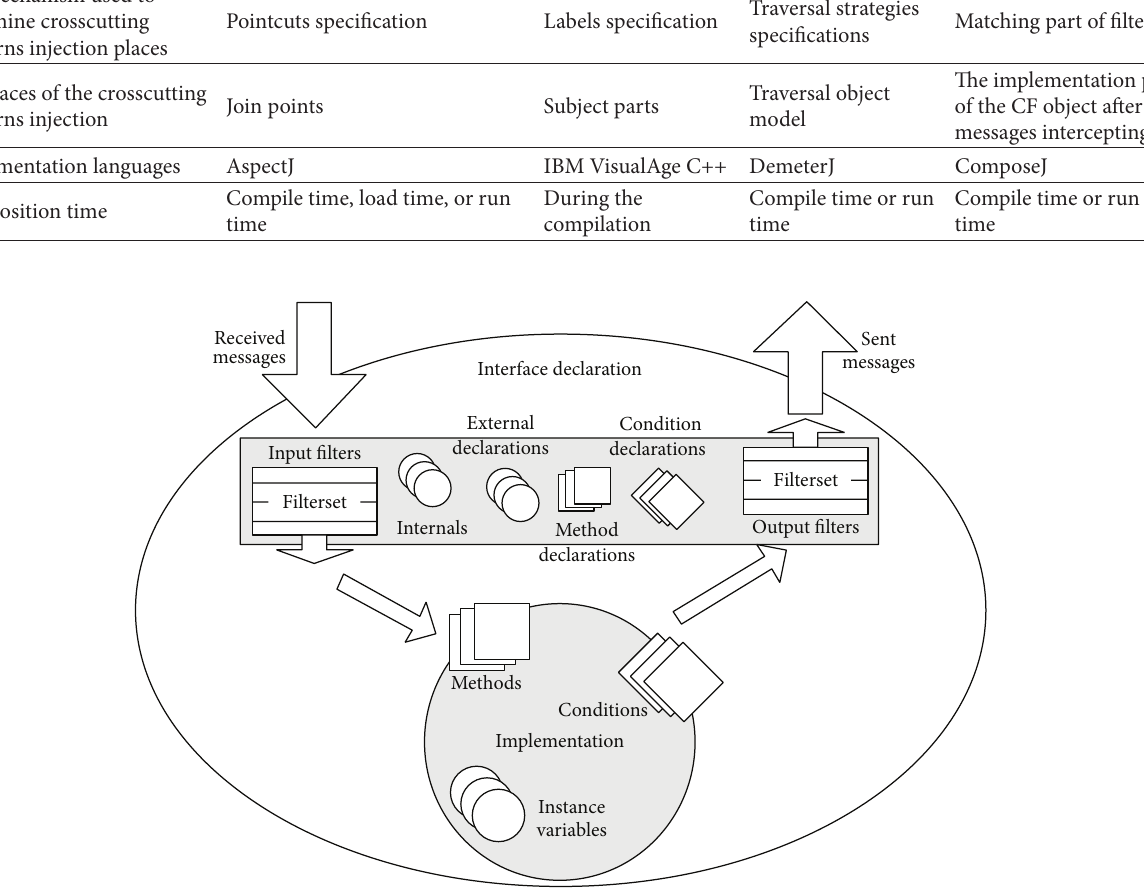
Figure 4: Composition filters object